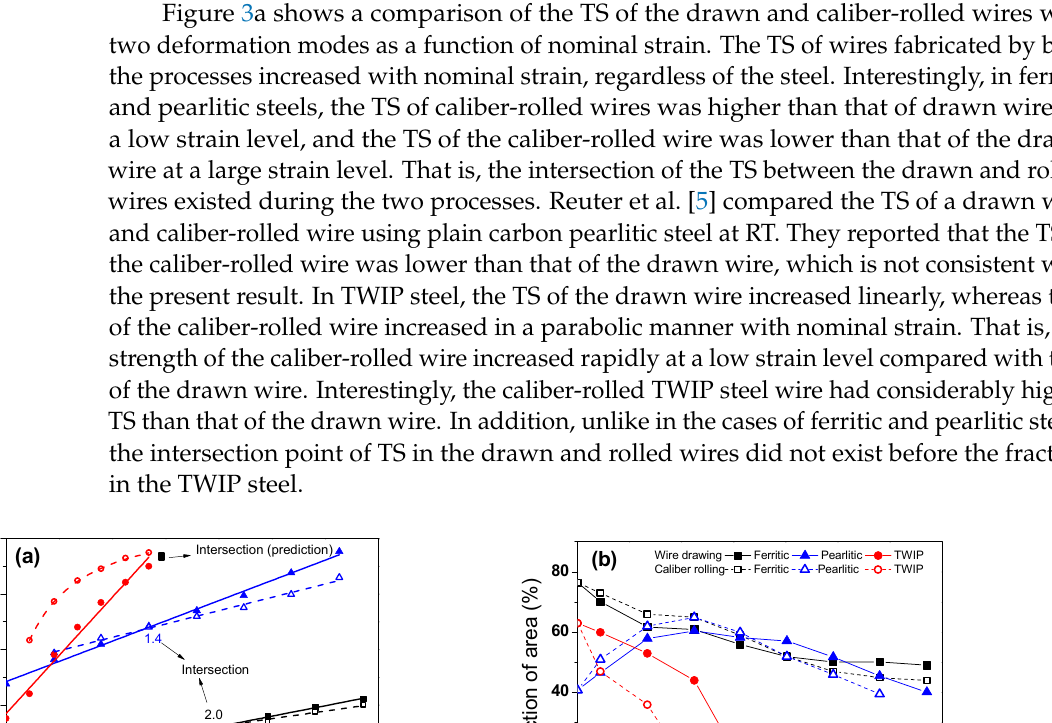
Figure 2. True stress-strain curves of hot-rolled ferritic, pearlitic, and TWIP steels.